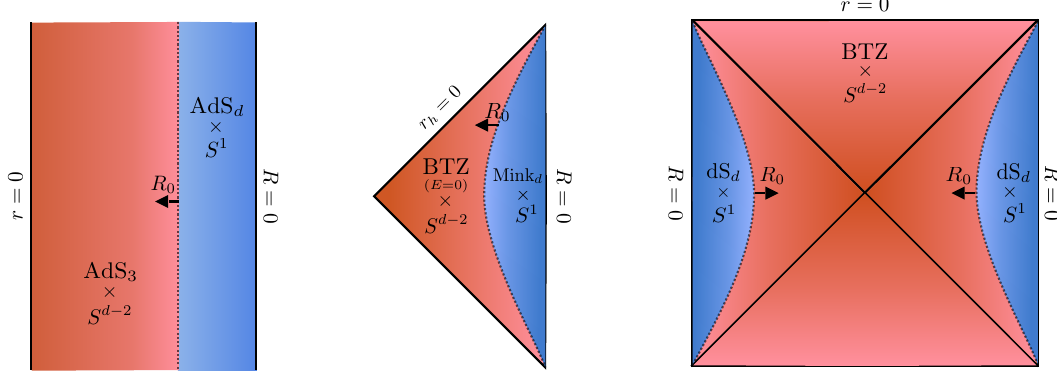
Figure 4 . The (cid:12)rst (cid:12)gure depicts, from left to right, the gluing of the [0 ; r AdS 3 S d (cid:0) 2 to the [0 ; R 0 ] region of AdS d (cid:2) the gluing of the [0 ; r 0 ] region of massless (Weyl rescaled) BTZ Mink d S 1 . Finally, the third (cid:12)gure shows the gluing of the [0 ; r 0 ] region of (Weyl rescaled) (cid:2) BTZ S d (cid:0) 2 to the [0 ; R 0 ] region of dS d (cid:2)